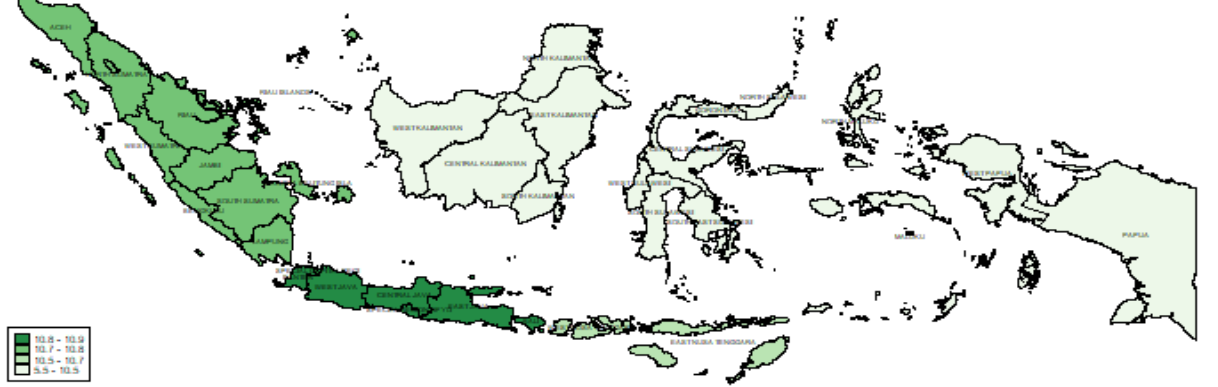
Figure 1. Mean presence of an information system by region. Table 1. Characteristics of the